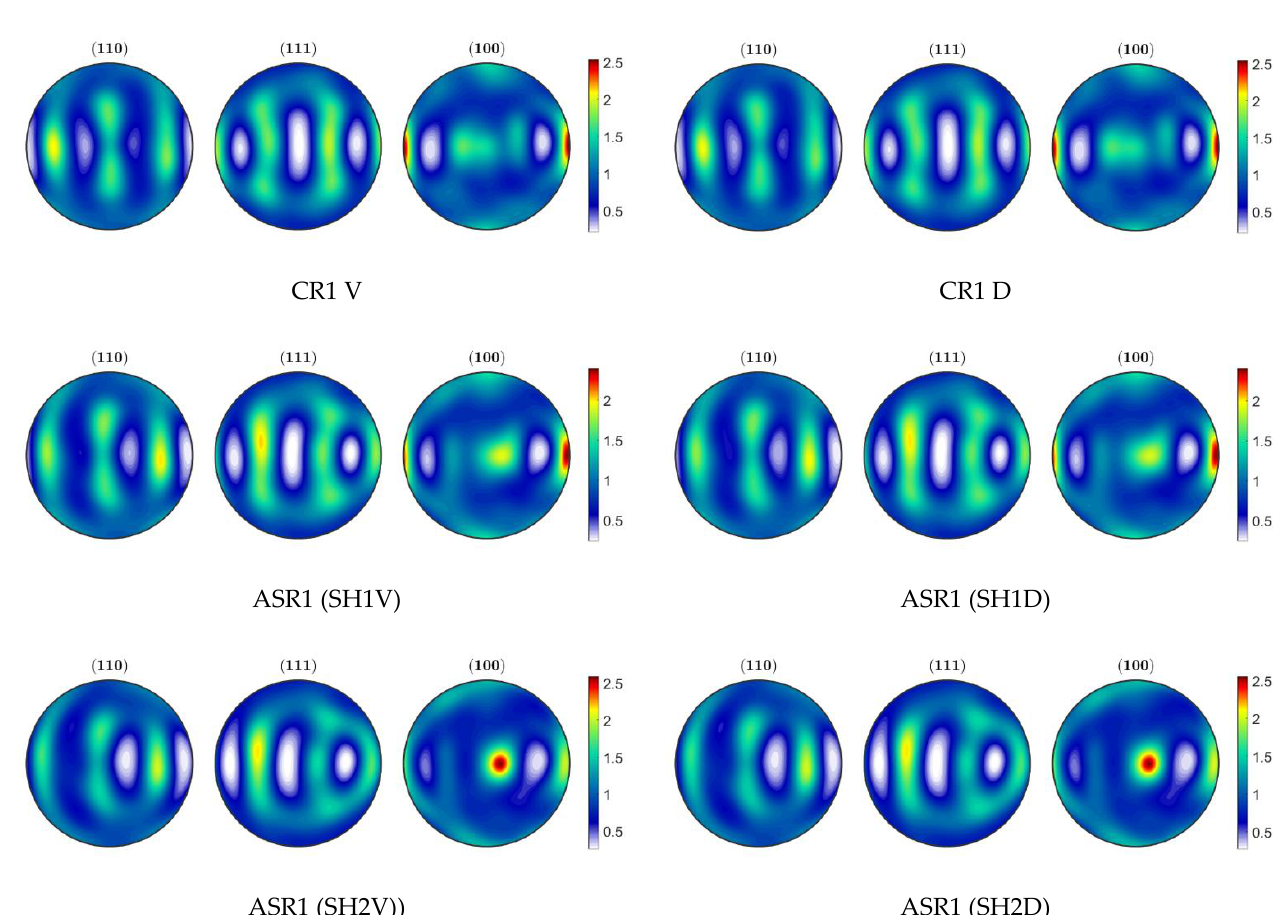
Figure A2. Pole figures for the first pass with a 20% thickness reduction per pass.